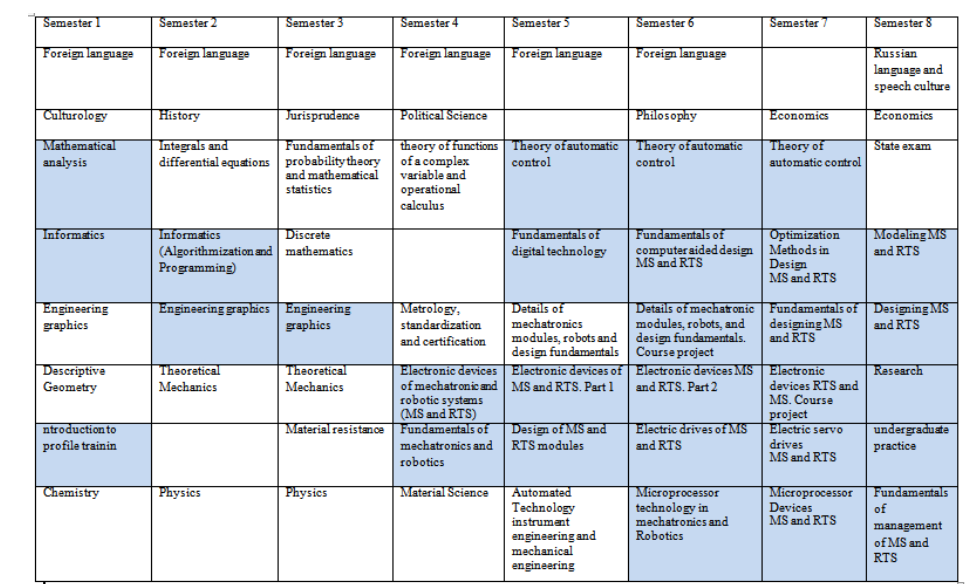
Fig. 1. Plan of bachelor.